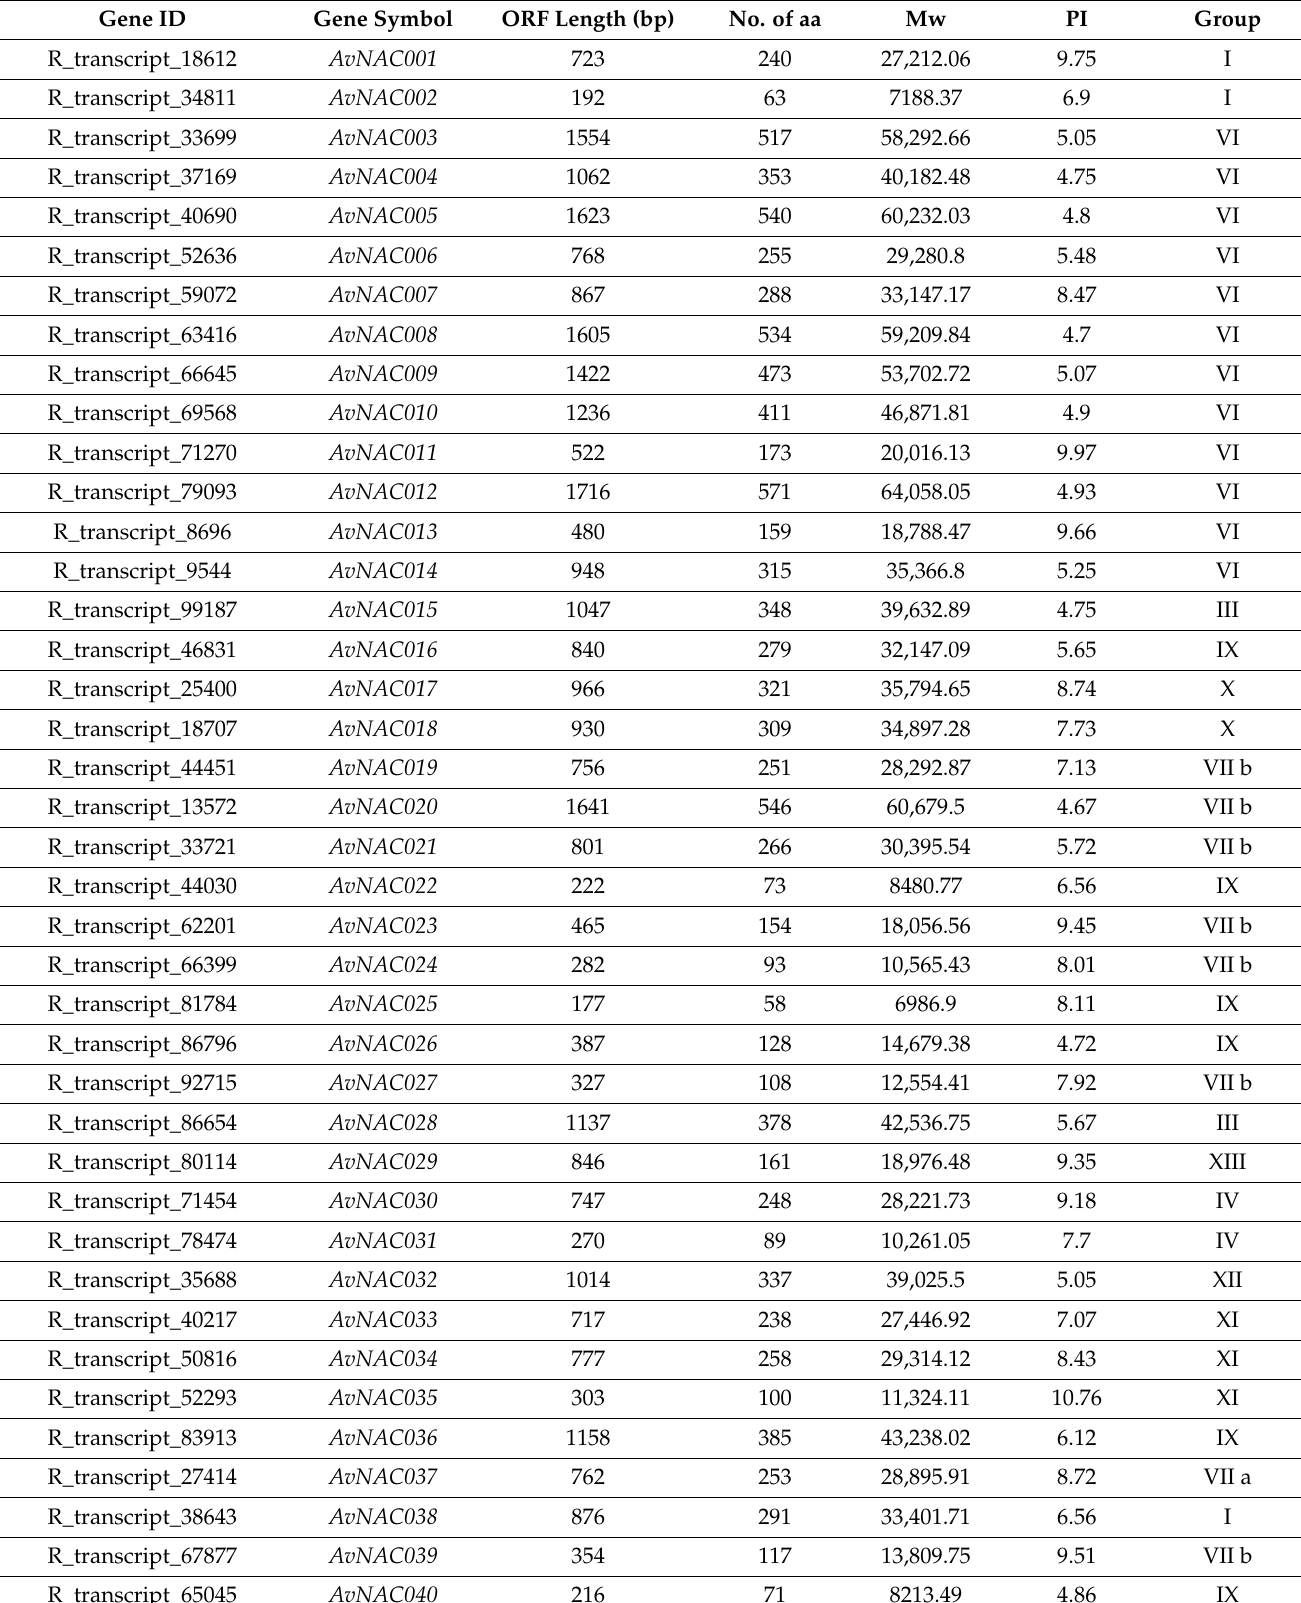
Table 3. Details of the VvSAUR family. Mw, molecular weight; PI, isoelectric